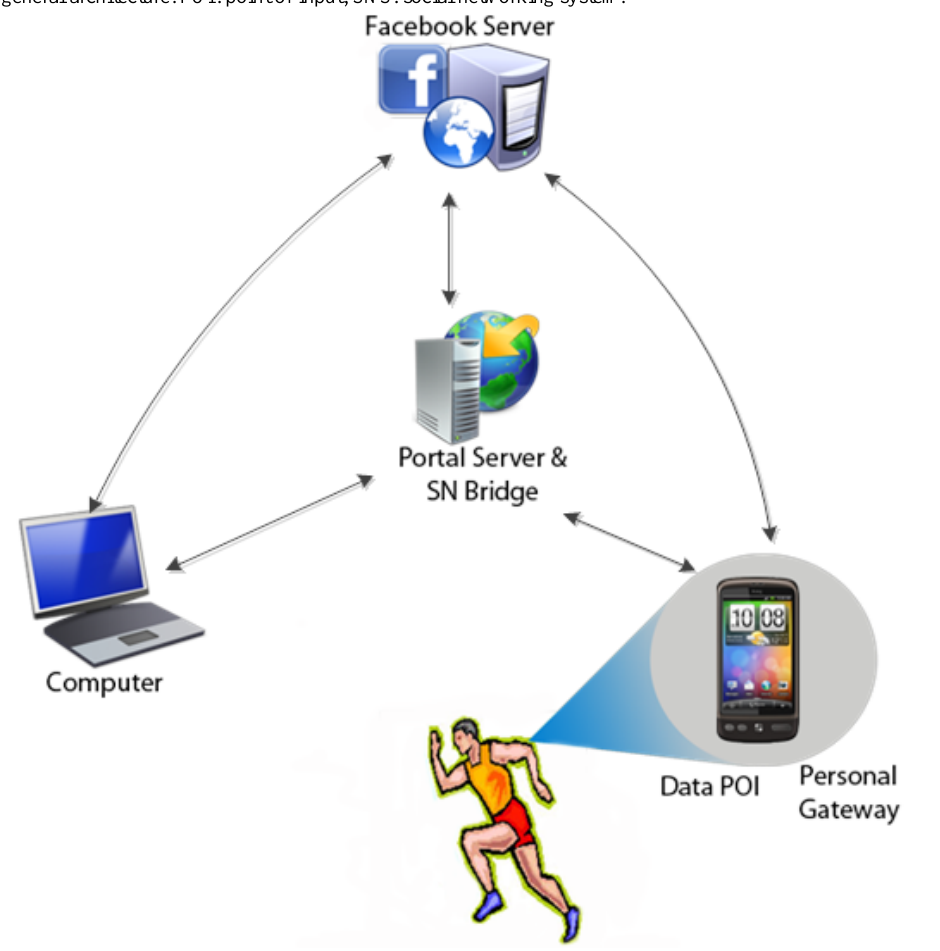
Figure 1. PersonA general architecture. POI: point of input; SNS: social networking